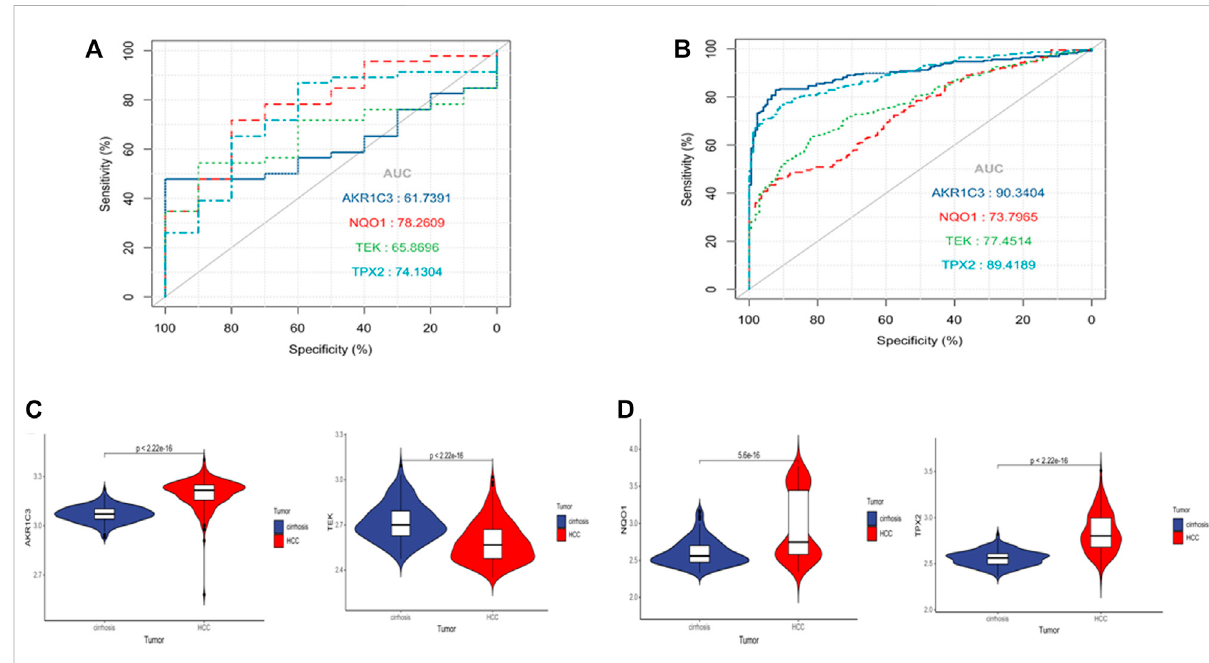
FIGURE 4 Analysis of the prognostic value of target genes. (A – D) Violin plots showing the relative expression of AKR1C3, NQO1, TEK and TPX2 in normal, cirrhotic and